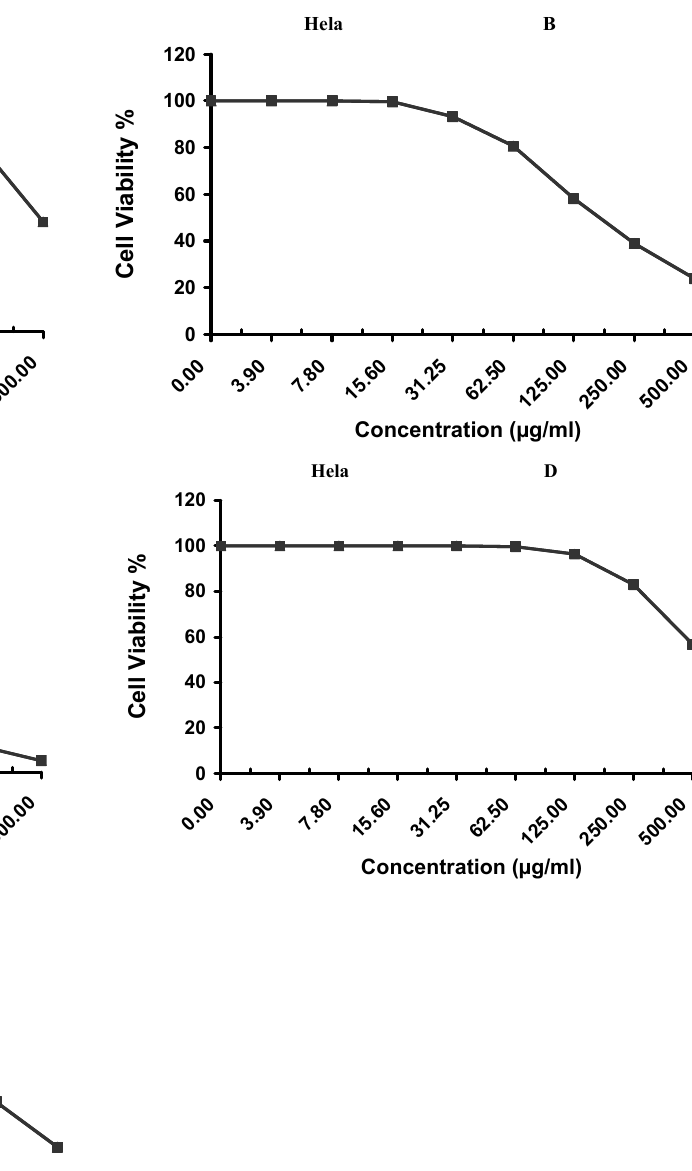
Figure A3. The percentage of cell viability of lung cancer cell lines (A-549) upon treatment with different doses of the test samples. ( A ) the unloaded PLGA NPs, ( B ) the PLGA-Cf-F 1 NPs, ( C ) the PLGA-Cf-F 2 NPs and ( D ) the PLGA-Cf-F 3 NPs. Finally, graph (E) is for the free coffee extract.